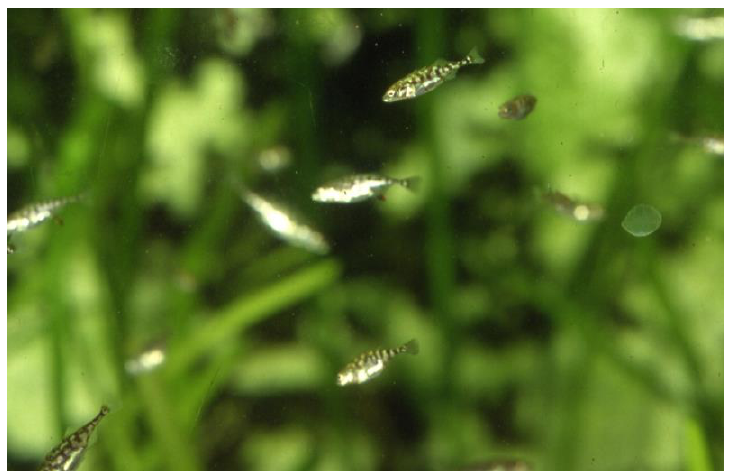
Figure 1 . Shoaling juvenile threespine sticklebacks (photo by T. C. M. Bakker).